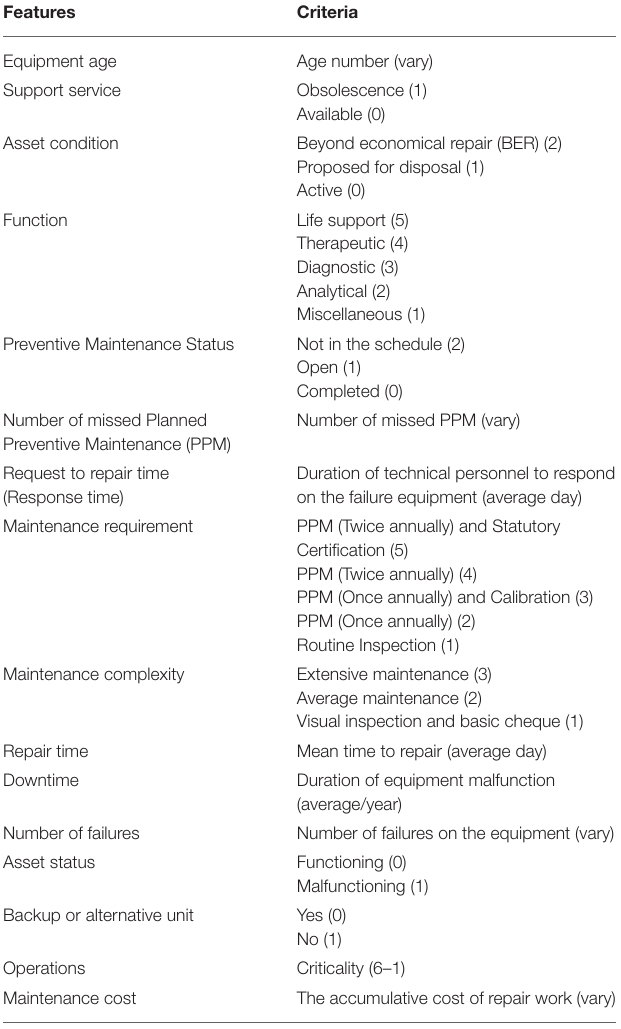
TABLE 3 | Medical equipment features and